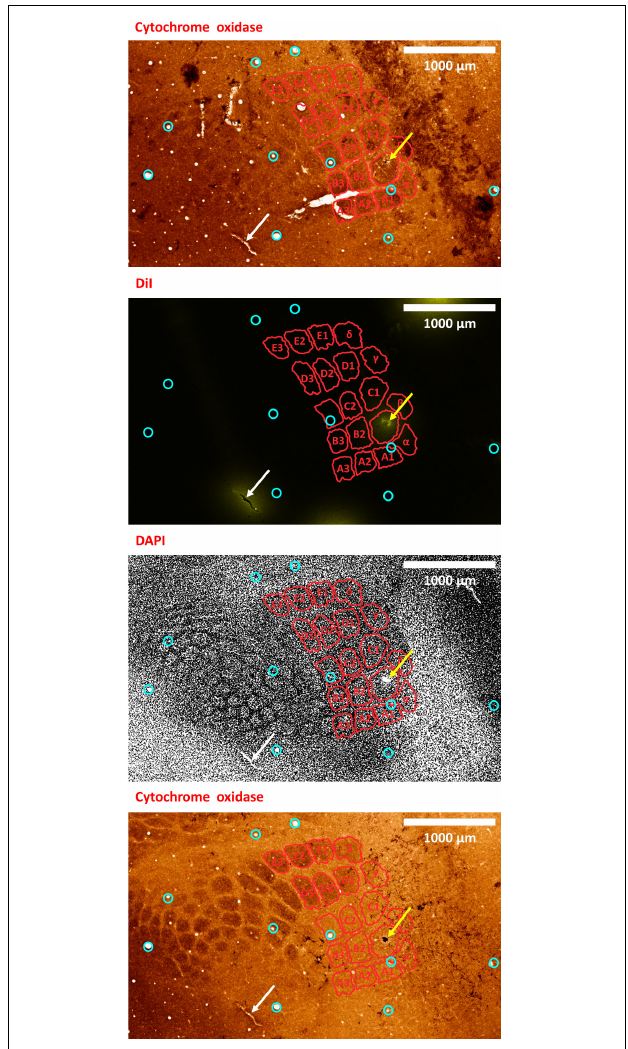
FIGURE 8 | A second example of verifying an electrode insertion into a pre-defined barrel using tissue processing. Post experiment histology was performed on the flattened cortex of the mouse right hemisphere, from which we present three consecutive slices. In all panels, red perimeters delineate the major barrels identified in the second panel, as localized using both cytochrome oxidase and DAPI, yellow arrows point to the insertion within the targeted barrel, and white arrows point to one of the four user-made DiI fiducial markers. The top-most and bottom-most panels present bright-field images of cytochrome oxidase staining of the first and third slices, respectively, showing the targeted B1 barrel. The second and third panels present the second slice imaged using different microscope filters; therefore, every pixel is perfectly co-localized between them. The second panel presents the DiI fluorescence imaging of the second slice. It shows the DiI fiducial markers as well as the recording site, using a TRITC filter with wavelength distribution centered at 580 nm. The third panel shows the DAPI counterstaining of cell bodies’ nuclei of this same slice, performed using a filter with wavelength distribution centered at 455 nm. A grayscale filter was applied to the DAPI image in order to improve visualization of the barrel field. Four user-made DiI fiducial markers were used for the initial co-registration of the slices. Ten penetrating blood vessels (cyan circles) were then used to optimize the fine-scale registration of the consecutive slices. The DiI-marked electrode insertion site (yellow arrow) is inside the pre-selected B1 barrel. The scale bar represents 1